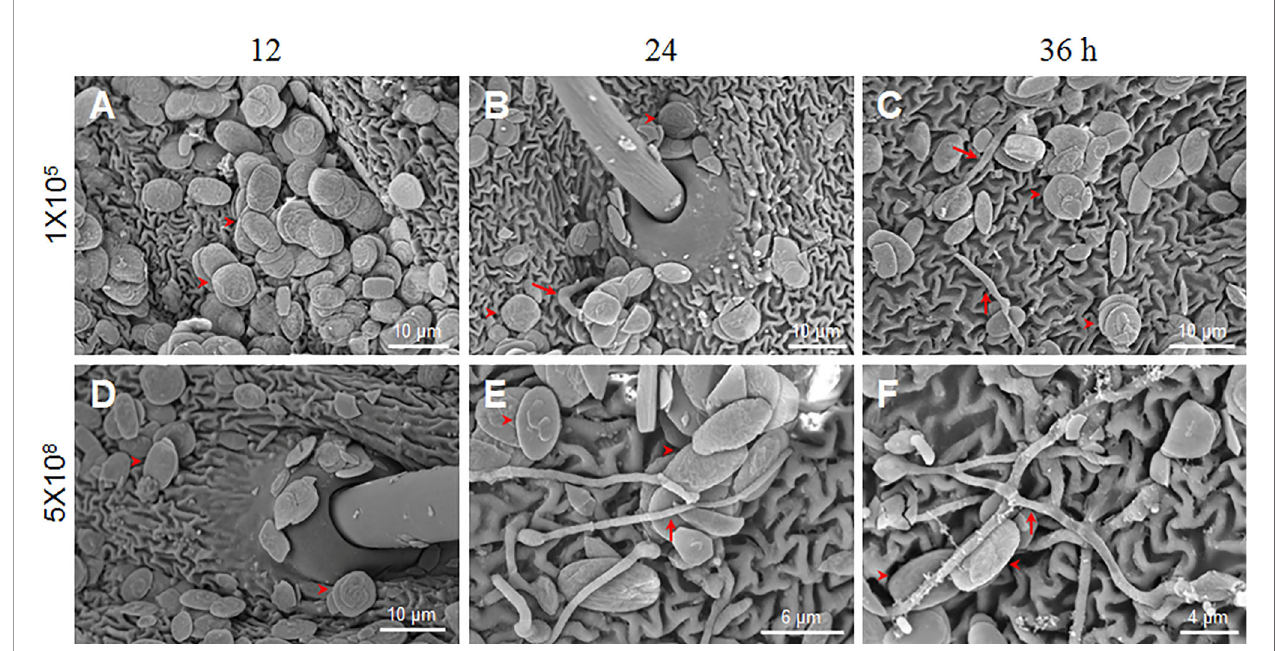
FIGURE 2 | B. bassiana conidia germination is dose-dependent. Scanning electron microscopy was utilized to observe conidia germination after the fi xed-site infection (1×10 5 and 5×10 8 spores/ml) at each indicated time point. In general, the number of conidia detected with 1×10 5 spores/ml (A – C) was less than 5×10 8 spores/ml (D – F) using scanning electron microscopy. To obtain additional information, we speci fi cally selected the area with many conidia for imaging when 1×10 5 spores/ml of conidia was inoculated. Few conidia germinated and mycelia were thin as indicated by the arrows (B, C) . When 5×10 8 spores/ml of conidia were inoculated, many conidia germinated and new hyphae were thick on the integument surface (E, F) . At 12 h, no germination occurred when either concentration of conidia was inoculated (A, D) . In each picture, the arrowheads indicate some conidia likely without